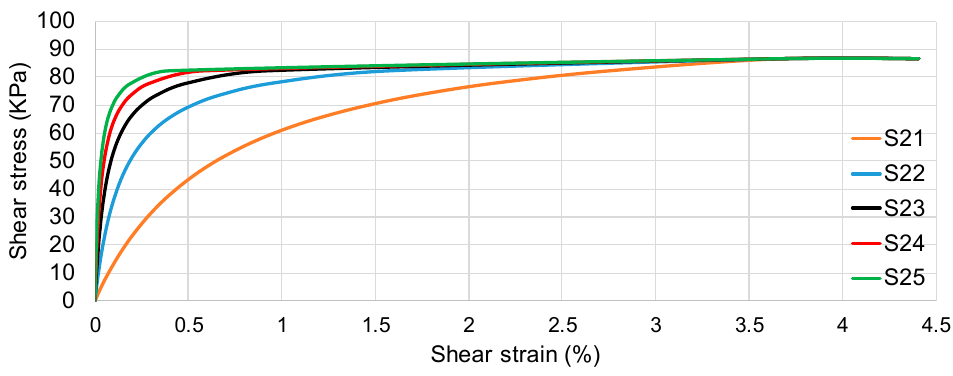
Figure 7. Backbone curve (S2 soil).